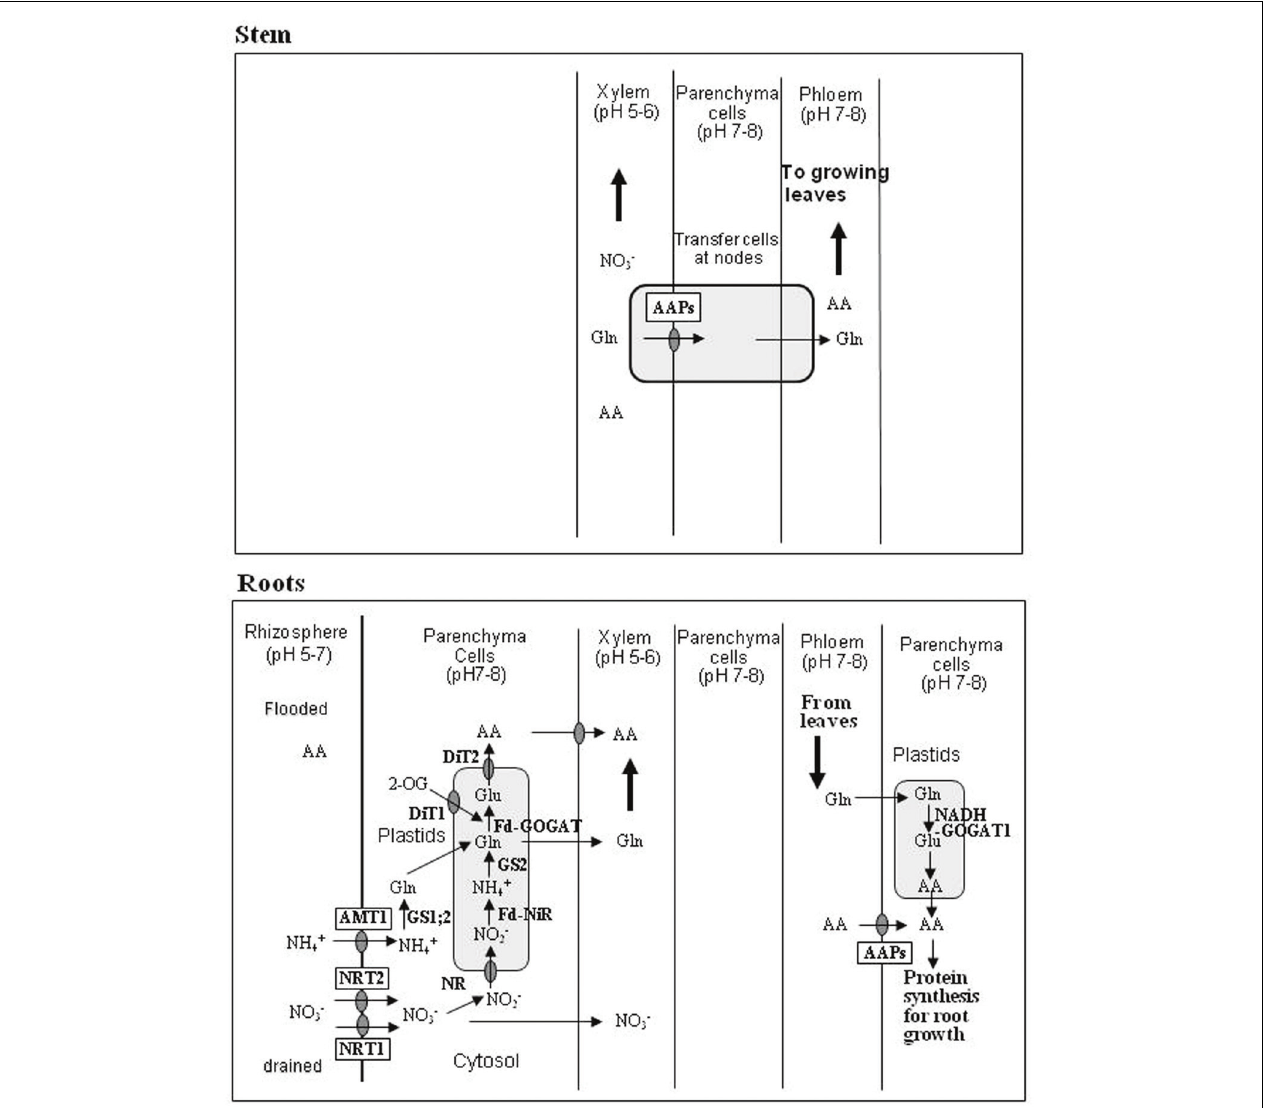
FIGURE 2 | Models for uptake, assimilation, and transport of N in stem and roots of rice. Abbreviations: AA, amino acids; AAPs, amino acid permeases; DiT1, 2-oxoglutarate translocator; DiT2, glutamate translocator; NRT1, low-affinity nitrate transporter; NRT2, high-affinity nitrate transporter.